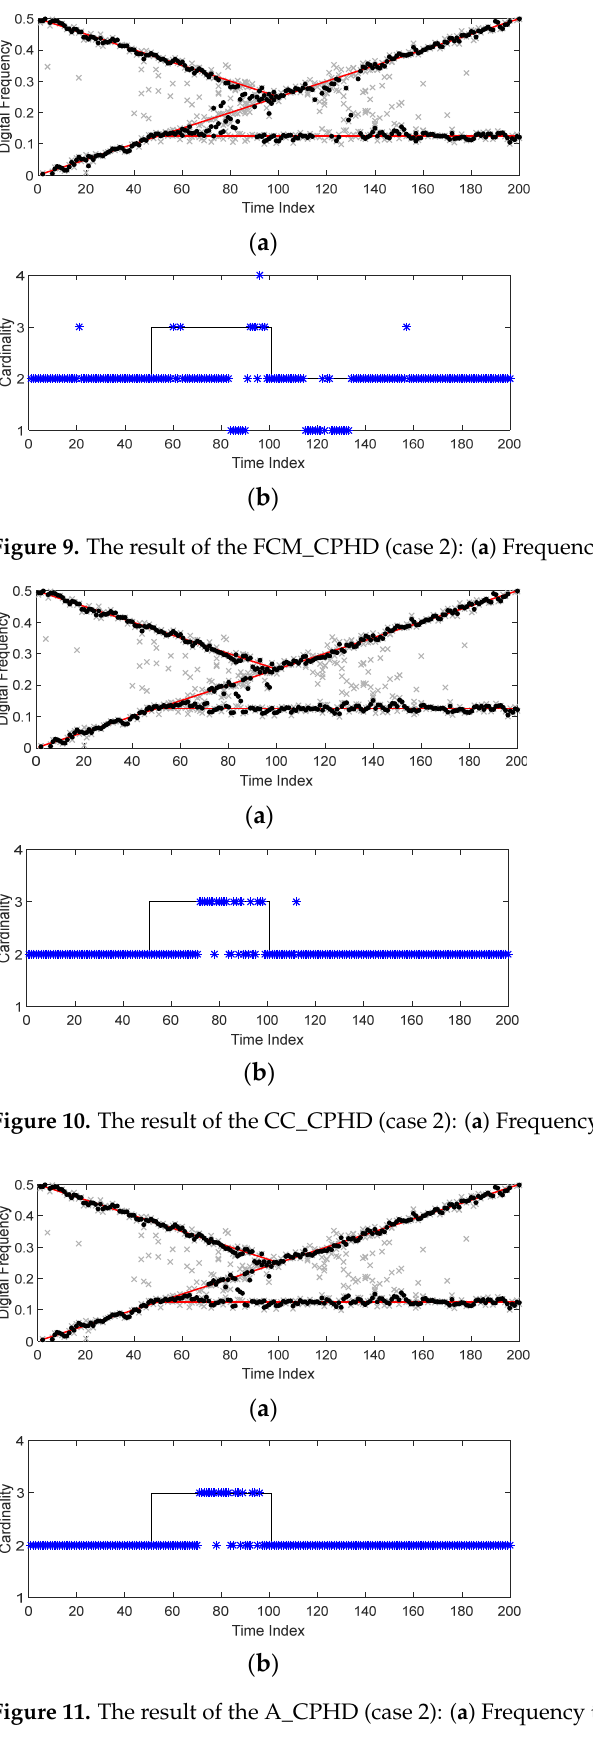
Figure 8. The result of the C_CPHD (case 2): ( a ) Frequency tracking; ( b ) Cardinality estimate.